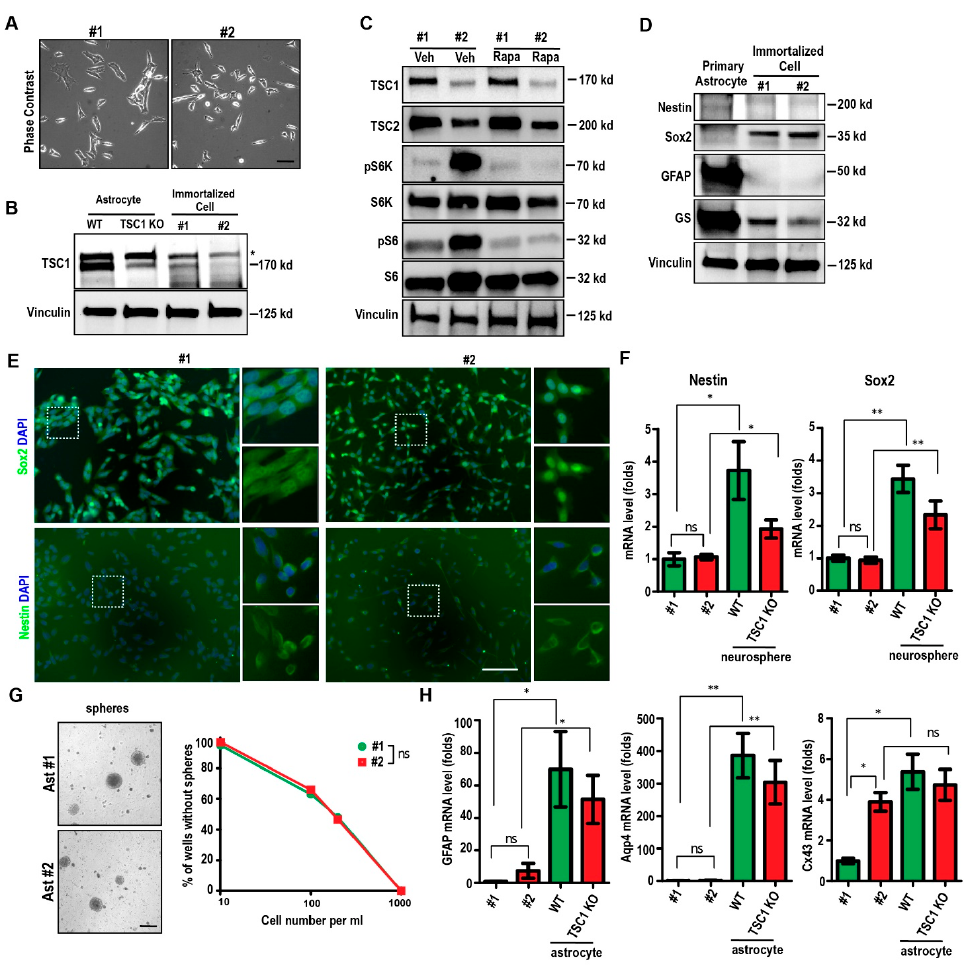
Figure 1. Characterization of immortalized cell lines Ast #1 and Ast #2 in vitro. ( A ) Phase contrast images of Ast #1 and Ast #2 cells after seeding for 1 day in culture. ( B ) Lysates extracted from primary astrocytes of WT mice and Tsc1 KO mice and immortalized astrocytic cell lines (#1 and #2) were analyzed by Western blot using antibodies for Tsc1 (top) and Vinculin (bottom). The star indicates a non-specific band revealed by Tsc1 antibody. Images were representative for 3 independent experiments. ( C ) Lysates from Ast #1 and Ast #2 treated with vehicle or Rapamycin for 24 h were analyzed by Western blot using antibodies for TSC1, TSC2, pS6K, total S6K, pS6RP, total S6RP, and Vinculin. Images were representative for 3 independent experiments. ( D ) Lysates extracted from primary WT astrocytes and immortalized cell lines were analyzed by Western blot using antibodies against GFAP, GS, Nestin, Sox2, and Vinculin as indicated. Images were representative for 3 independent experiments. ( E ) Immunofluorescent staining of Sox2 (upper panels), nestin (bottom panels), and DAPI in immortalized astrocytic cell lines. Boxed areas were shown in details on the right. ( F ) Mean ± S.E. of the relative mRNA expression levels of nestin and Sox2 from Ast #1, Ast #2, and neurospheres from WT mice and Tsc1 cKO mice were shown. Four independent experiments were performed with similar results. ( G ) Phase contrast images of sphere formation from Ast #1 and Ast #2 cells. The sphere formation efficiency from serial diluted Ast #1 and Ast #2 at number of 10 cells per mL, 100 cells per mL, 200 cells per mL, and 1000 cells per mL are shown. Three independent experiments were performed with similar results. ( H ) Mean ± S.E. of the relative mRNA expression levels of GFAP , Aqp4 , and Cx43 from Ast #1, Ast #2 and astrocytes from WT and Tsc1 cKO mice were shown. Four independent experiments were performed with similar results. Two-way ANOVA and Tukey post hoc tests were used for statistic tests. ns: no significance; * p < 0.05, ** p < 0.01. Bar = 30 µ